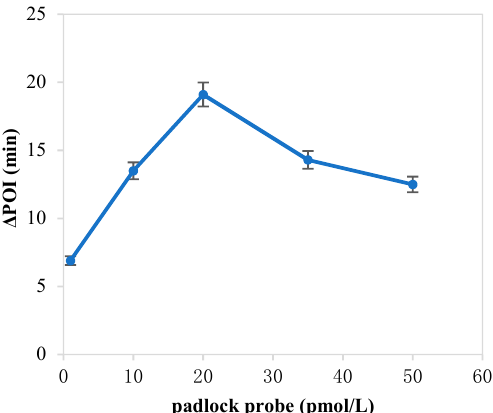
Figure 1. The optimization of the concentration of padlock probe on the RC-LAMP assay. The graph shows the Δ POI value vs. the concentration of padlock probe. Experimental conditions: miR-200a 1 pmol/L, T4 DNA ligase 70 U, FIP/BIP 800 nmol/L and amplification temperature 62 ◦ C, respectively.